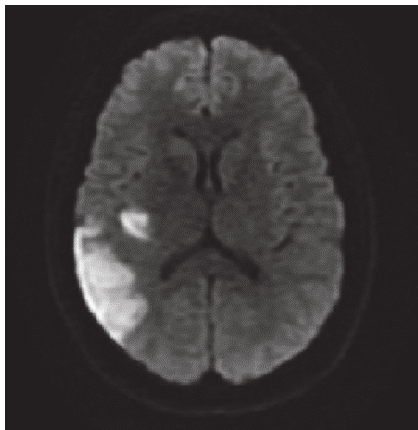
Figure 1: Axial images of diffusion-weighted MRI of the brain with contrast showing hyperintensity in the temporal and occipital lobes.